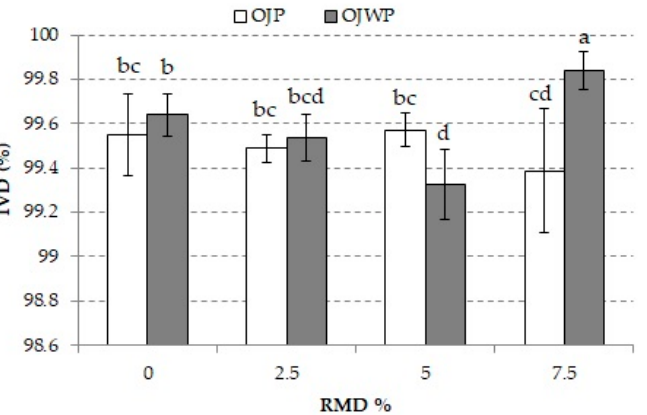
Figure 4. Mean values and standard deviation of IVD percentage of pasteurized orange juice (OJP and OJWP) with 0, 2.5, 5, and 7.5 RMD%. Letters indicate homogeneous groups established by the ANOVA ( p < 0.05). OJP, orange juice with pulp; OJWP, orange juice without